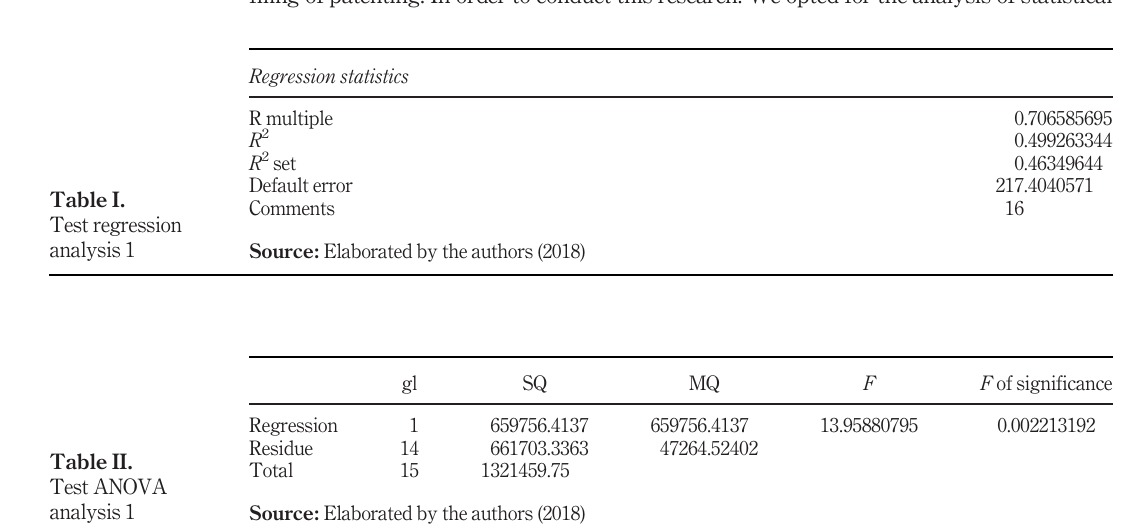
Table II. Test ANOVA analysis